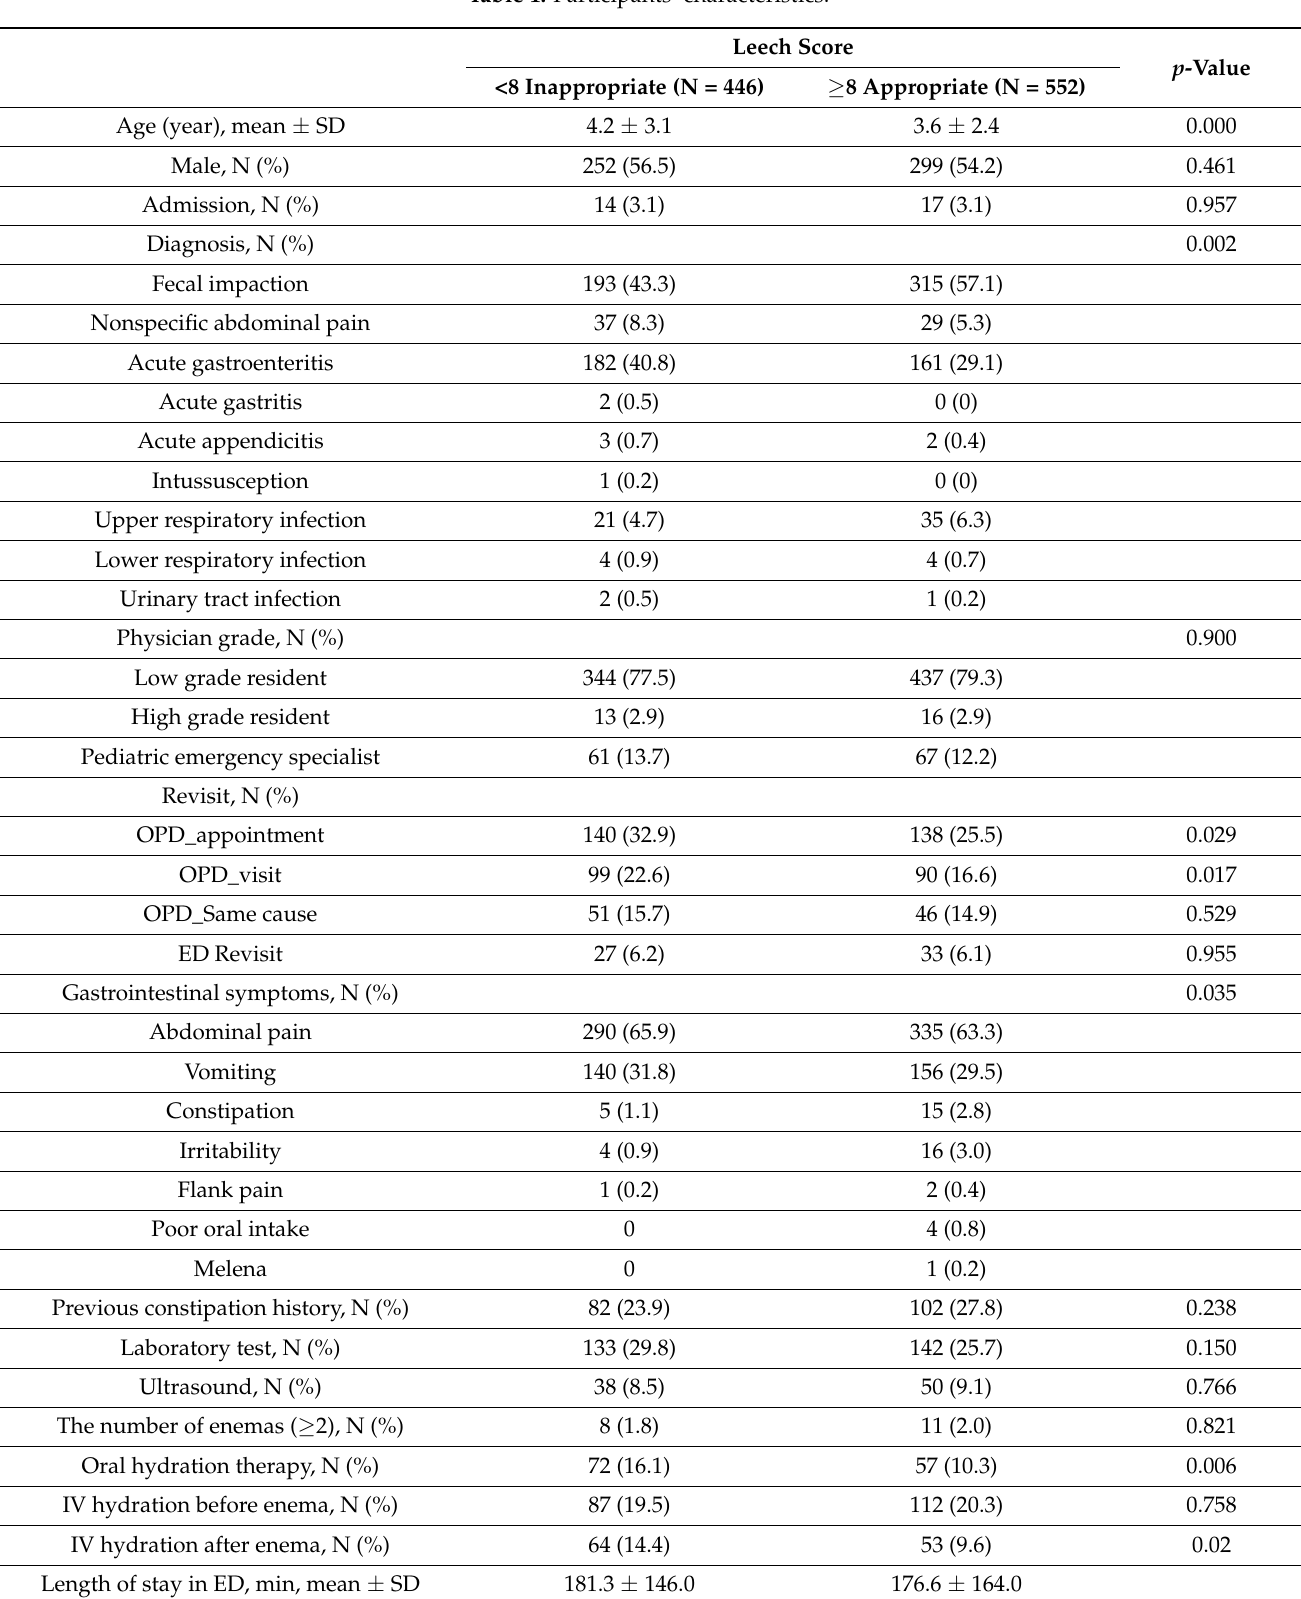
Table 1. Participants’